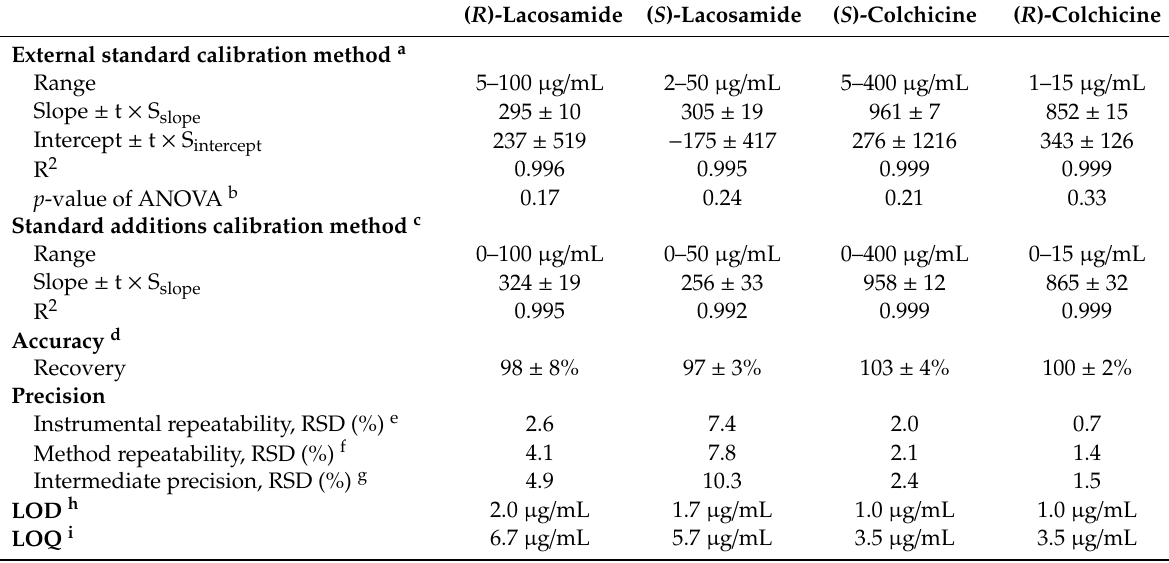
Table 1. Analytical characteristics of the nano-LC methodology developed for the enantiomeric determination of lacosamide and colchicine in pharmaceutical formulations using an amylose-based chiral stationary